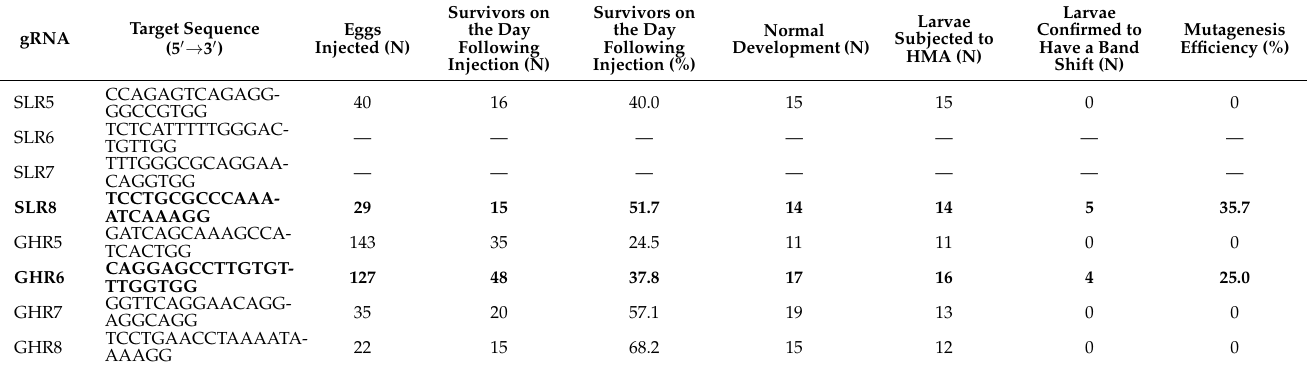
Table 1. gRNA target sequences and mutagenesis efficiency for the SLR and GHR genes in G 0 fish.